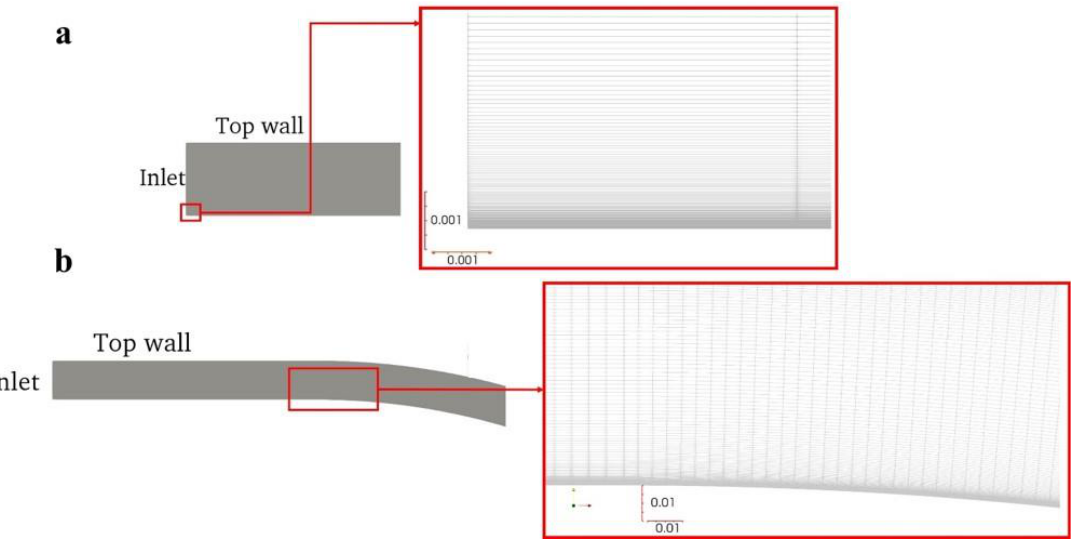
Figure 2. Close view on the mesh in the near-wall region: ( a ) Inlet area; ( b ) transition straight/curved zone (scale in m).